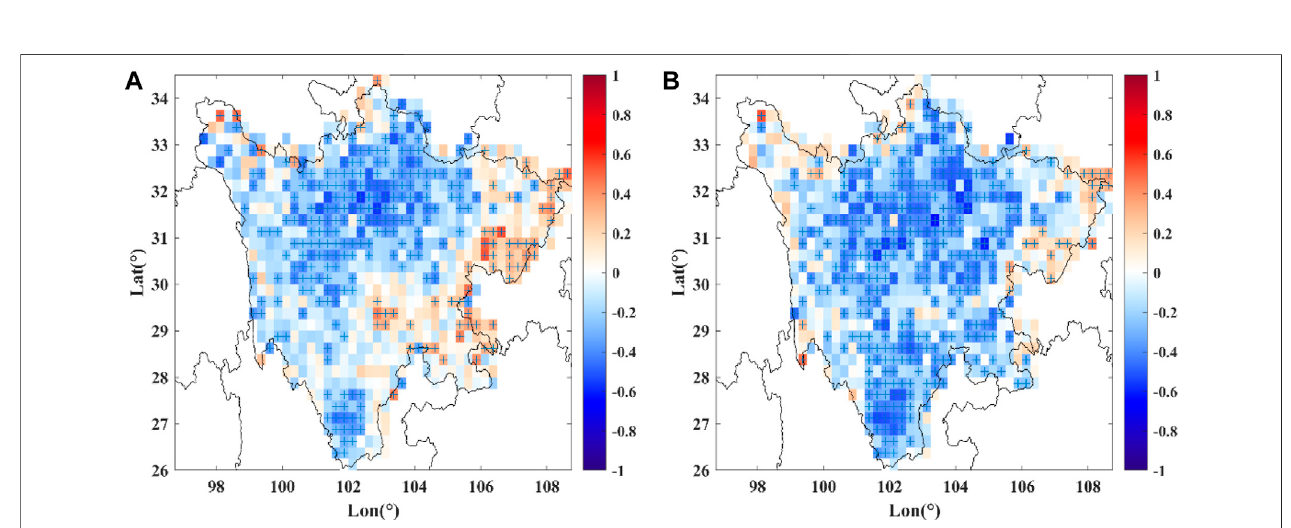
FIGURE 3 | Annual variations of (A) total CG lightning density, (B) relative frequency of positive CG lightning (PRF), (C) sulfate AOD, and (D) BC AOD in the basin and plateau regions during the warm season.